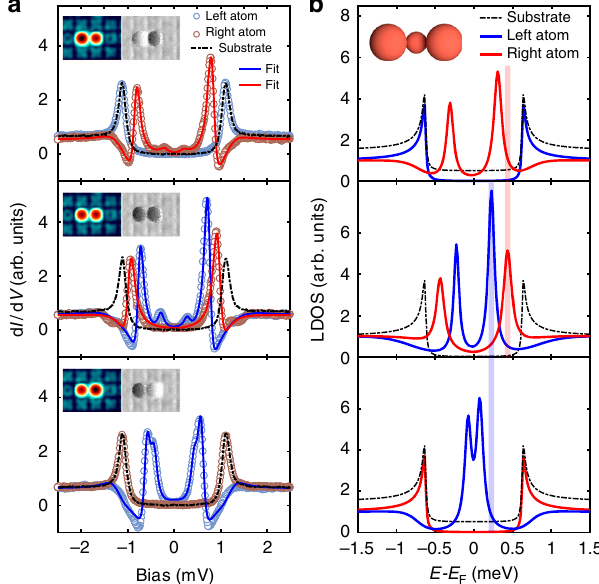
Fig. 4 Spectroscopy on a pair with one IFA in the center. a d I /d V spectra taken with a superconducting tip on the two adatoms plotted together with substrate spectrum for the three cases: (1) top panel: left atom in YSR-off state and right atom in YSR-on state, (2) middle panel: both atoms in YSR- on state, (3) bottom panel: left atom in YSR-on state and right atom in the YSR-off state. The solid curves in each panel represent a fi t using the numerical deconvolution. Insets in each panel are the corresponding STM and d I /d V images. b The numerically deconvoluted LDOS corresponding to the fi ts in each panel in a . The black dashed curve corresponding to the substrate DOS is shown in each panel as a reference. Vertical lines are a guide to the eye showing shifts in the YSR state energy from the case (2) to the cases (1), (3). The pictogram in the upper panel shows the position of the Fe atoms in the assembly. Substrate DOSs in upper and lower panels are shifted vertically for clarity. Stabilization parameters for STS: V stab =